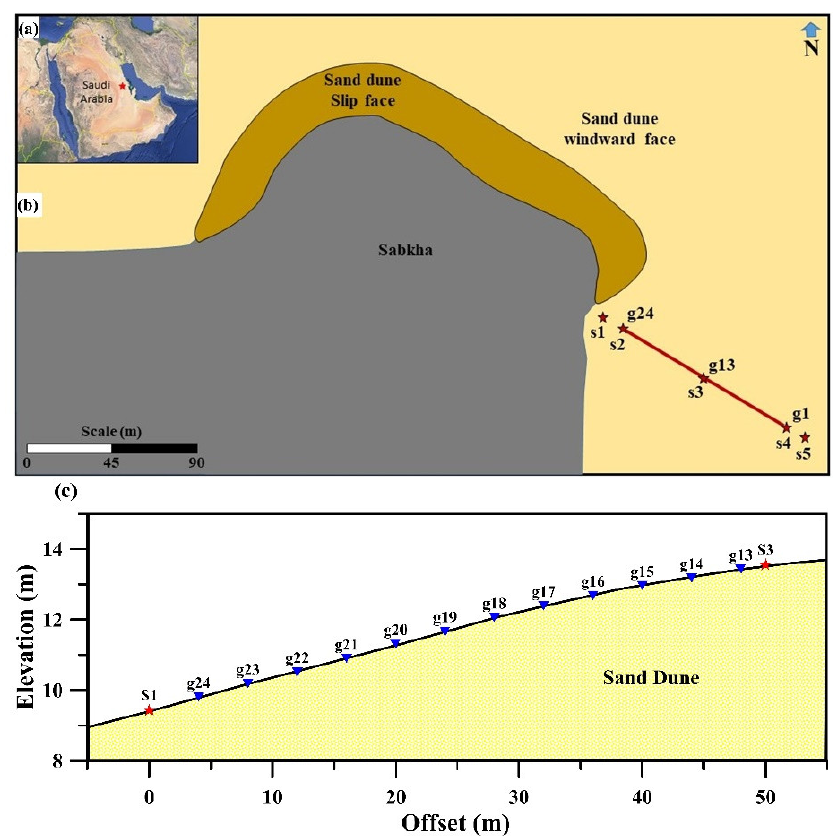
Figure 3. ( a ) Satellite view showing Saudi Arabia and the study area marked with red stars; ( b ) image showing the study area with the seismic line (red line); and ( c ) the seismic line including 12 receivers (blue triangles) and two sources (red stars) with their actual positions and elevations using D-GPS data.